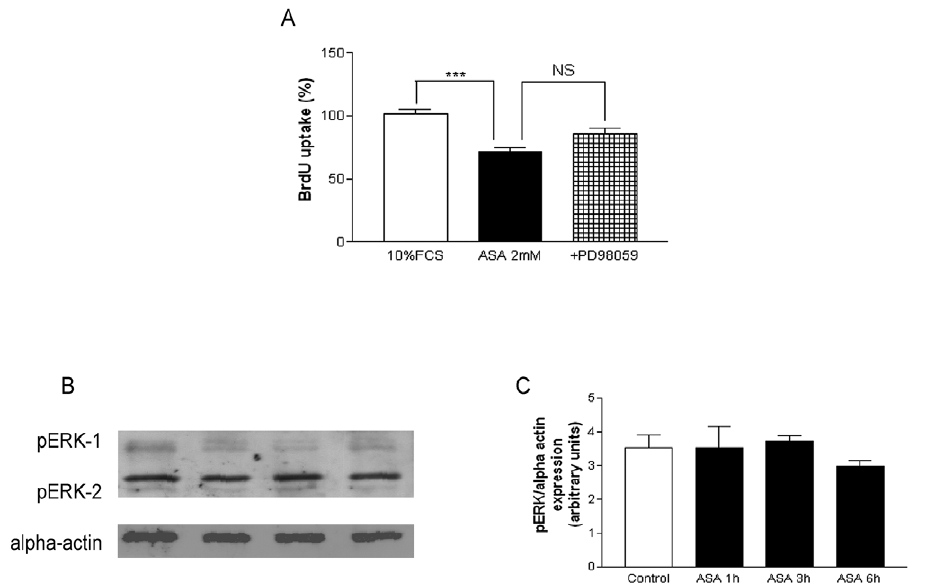
Figure 5. The ERK MAPK pathway is not involved in the antiproliferative effect of ASA. Panel A: Effect of the ERK MAPK blocker PD98059 when added to ASA (2 mM). DNA synthesis was assessed by BrdU uptake, as stated in Methods. Panel B: Representative blotsofERK MAPK phosphorylation (2 mM). Panel C: Quantification of pooled results. Bar graphs show the mean 6 S.E.M of n=4 experiments (cell cultures from 4 different patients). *** P , 0.001.